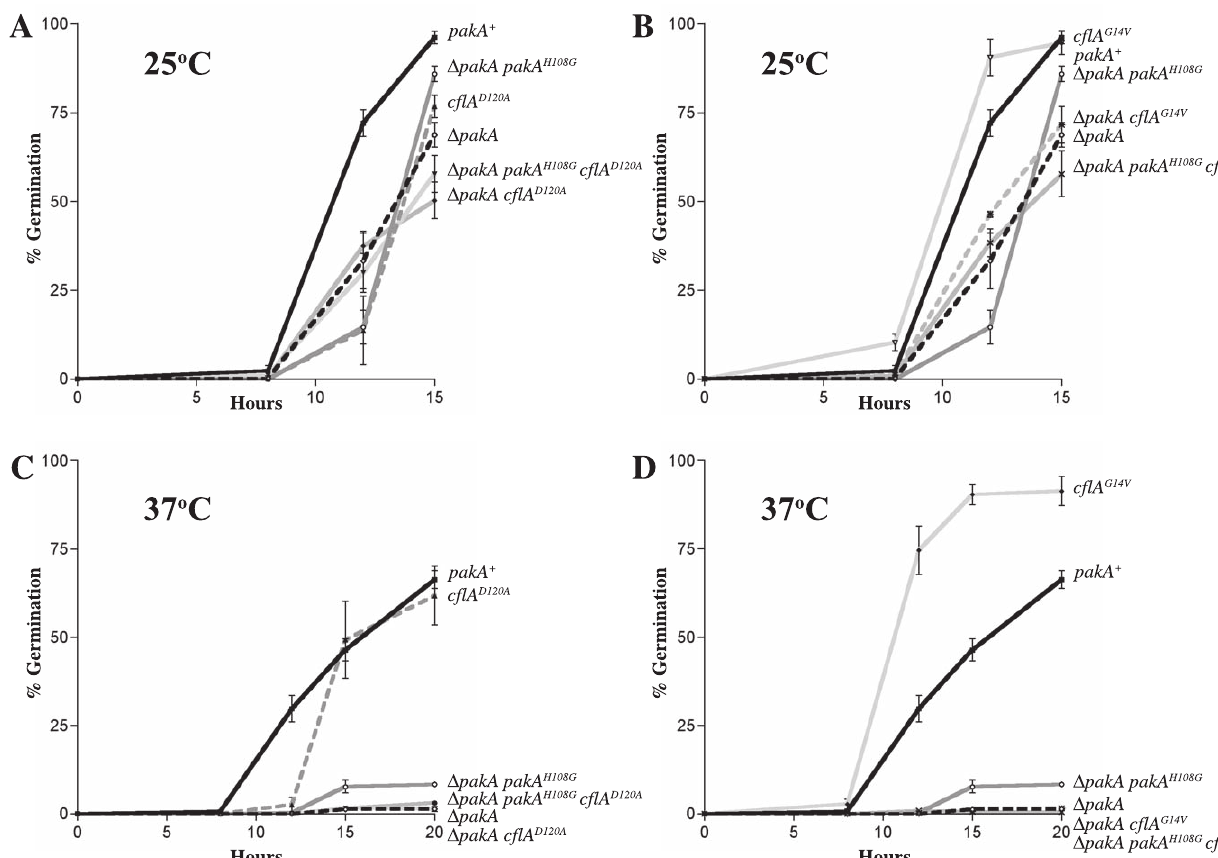
Figure 6. PakA Is Required for CflA-Dependent Germination at Both 25 8 C and 37 8 C The percentage of germinated conidia was measured in wild-type ( pakA þ ), cflA D120A , D pakA , D pakA pakA H108G , D pakA cflA D120A , and D pakA pakA H108G cflA D120A strains after incubation at 25 8 C for 8, 12, and 15 h (A) and at 37 8 C for 8, 12, 15, and 20 h (C). The percentage of germinated conidia was measured in wild-type ( pakA þ ), cflA G14V , D pakA, D pakA pakA H108G , D pakA cflA G14V , and D pakA pakA H108G cflA G14V strains after incubation at 25 8 C for 8, 12, and 15 h (B) and at 37 8 C for 8, 12, 15, and 20 h (D). One representative strain of each genotype is shown. Three independent experiments were performed and standard error of the mean bars are shown. (A, B) At 25 8 C, the D pakA and D pakA pakA H108G strains show a delay in germination when compared with the wild-type control. (A) Compared with the wild type ( pakA þ ), the cflA D120A strain shows delayed germination at 25 8 C. The D pakA cflA D120A and D pakA pakA H108G cflA D120A strains show delayed germination similar to the D pakA and D pakA pakA H108G strains. (B) Compared with wild type ( pakA þ ), the cflA G14V strain shows accelerated germination. The D pakA cflA G14V and D pakA pakA H108G cflA G14V strains show delayed germination similar to the D pakA and D pakA pakA H108G strains. (C, D) At 37 8 C, the D pakA and D pakA pakA H108G strains display a dramatic reduction in the number of germinated conidia when compared with wild type ( pakA þ ). (C) Compared with the wild type ( pakA þ ), the cflA D120A strain shows delayed germination at 37 8 C. The D pakA cflA D120A and D pakA pakA H108G cflA D120A strains show delayed germination similar to the D pakA strain. (D) In contrast to wild type ( pakA þ ), the cflA G14V strain exhibits accelerated germination at 37 8 C. The D pakA cflA G14V and D pakA pakA H108G cflA G14V strains show dramatically reduced germination at 37 8 C similar to the D pakA and pakA H108G strains.